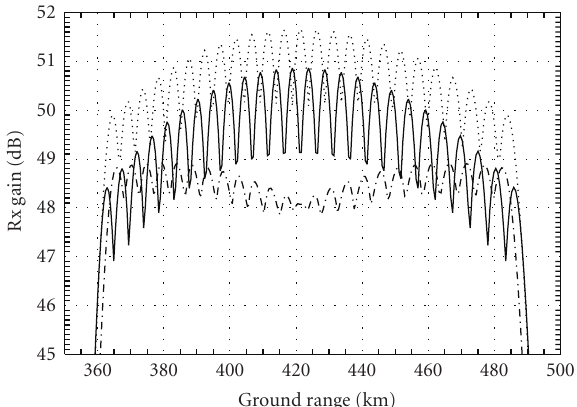
Figure 15: Transmit power pattern with 26 elements activated.